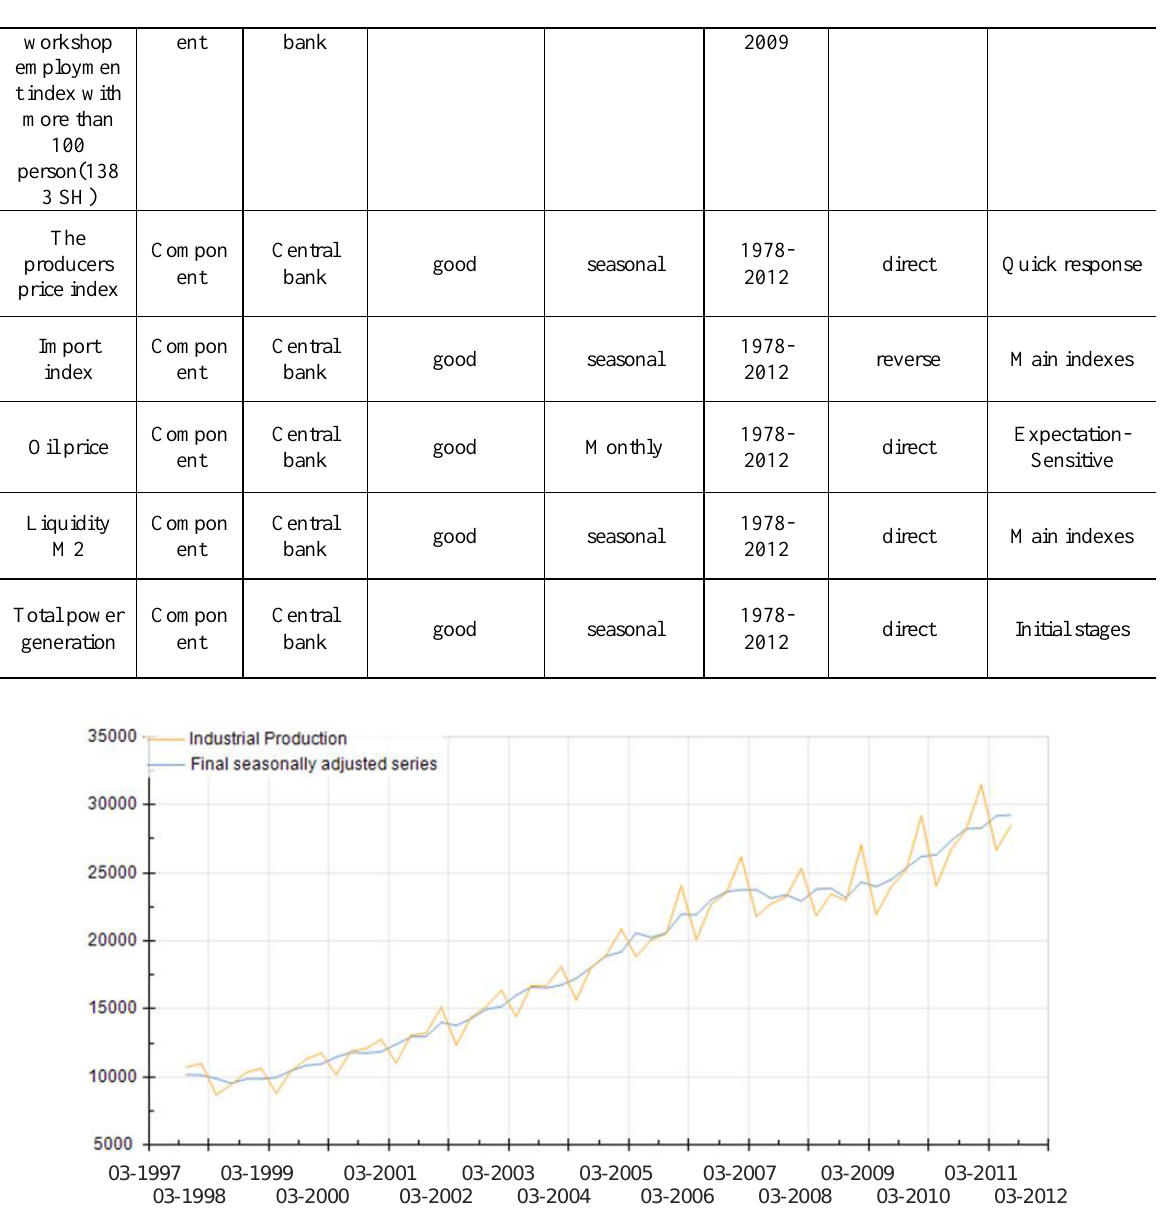
Figure 3. Value added of an industry before and after seasonal